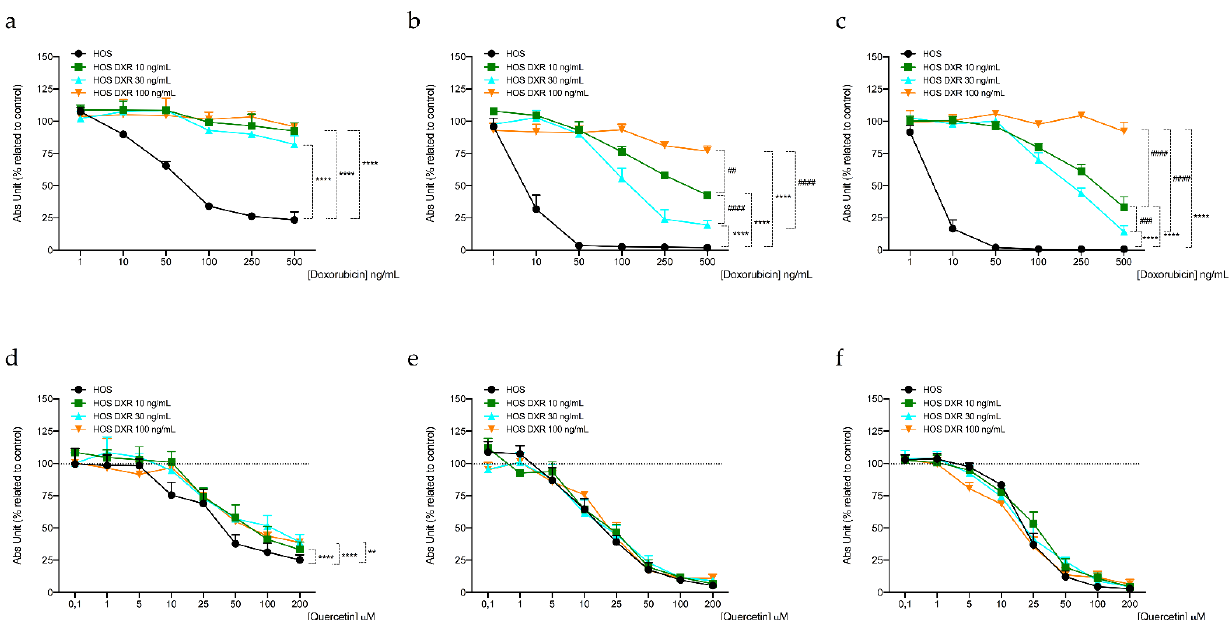
Figure 8. Evaluation of cell viability in HOS, HOS DXR 10 ng/mL, HOS DXR 30 ng/mL, and HOS DXR 100 ng/mL following treatment with DXR ( a – c ) and quercetin combined with DXR 10, 30 and 100 ng/mL, respectively, ( d – f ) for 24 ( a – d ), 48 ( b – e ), and 72 h ( c – f ). Data represent mean ± SD of three different experiments. ** p < 0.01, **** p < 0.0001, resistant vs. sensitive cells; ## p < 0.01, ### p < 0.001, 10 clones. Table 1. Cytotoxic effect of quercetin (calculated as IC 50 ) after 24, 48, and 72 h of treatment in MG63,